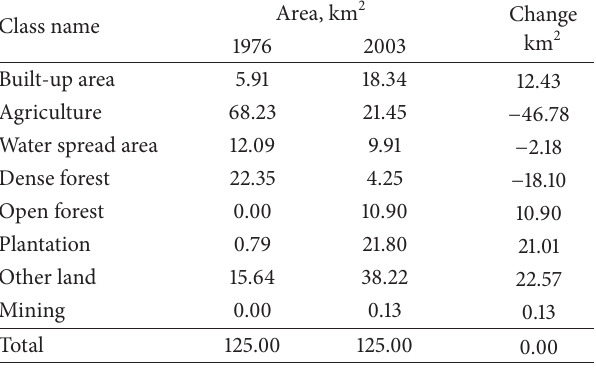
Table 2: Land use/land cover changes from 1976 to